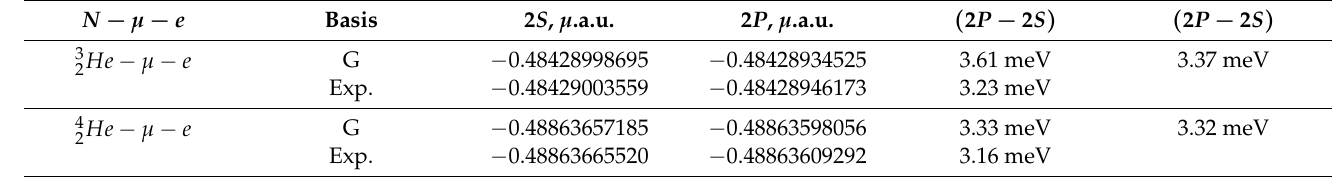
Figure 2. The radial distribution density W ( ρ , λ ) for ( µ e 3 He ) . The variable values ρ and λ are presented in muonic atomic units. Table 1. Numerical values of the Coulomb corrections of the muon Lamb shift. The abbreviations G and Exp. denote Gaussian and exponential trial wave functions. The last column presents the results of the analytical calculation of the Lamb